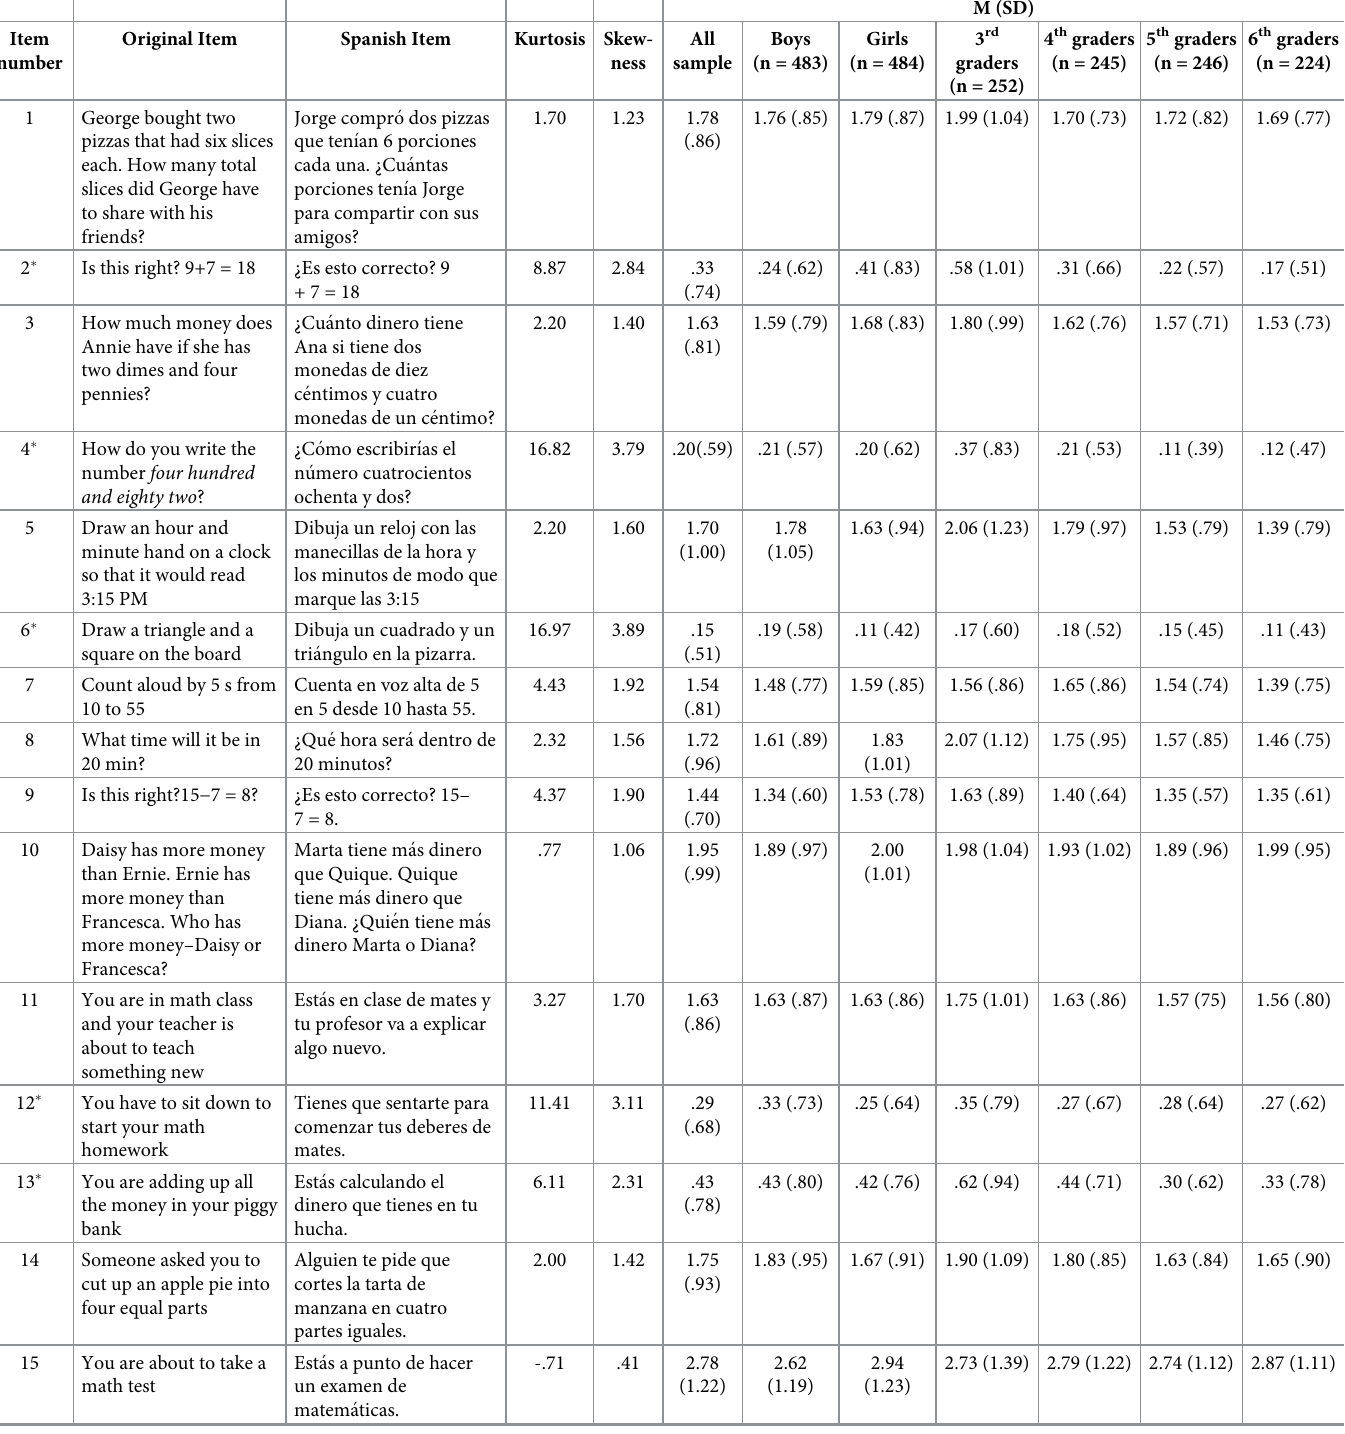
Table 1. Descriptive statistics for the SEMA items and